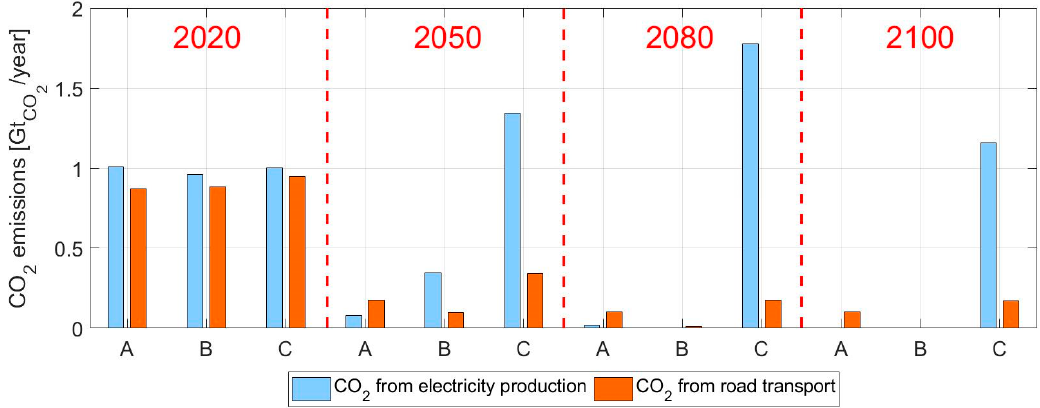
Figure 13. Comparison of CO 2 emissions from total electricity production and road vehicles at selected time steps, for the di ff erent storylines. The constantly growing electricity demand (above all from the transportation sector) reflects in an environmental-responsible adaptation of the production mix in storylines A and B , while the high uptake of electric vehicles in storyline C contributes to an uncontrolled growth of CO 2 (until 2080) from electricity production, making the radical changes in transportation almost ine ff